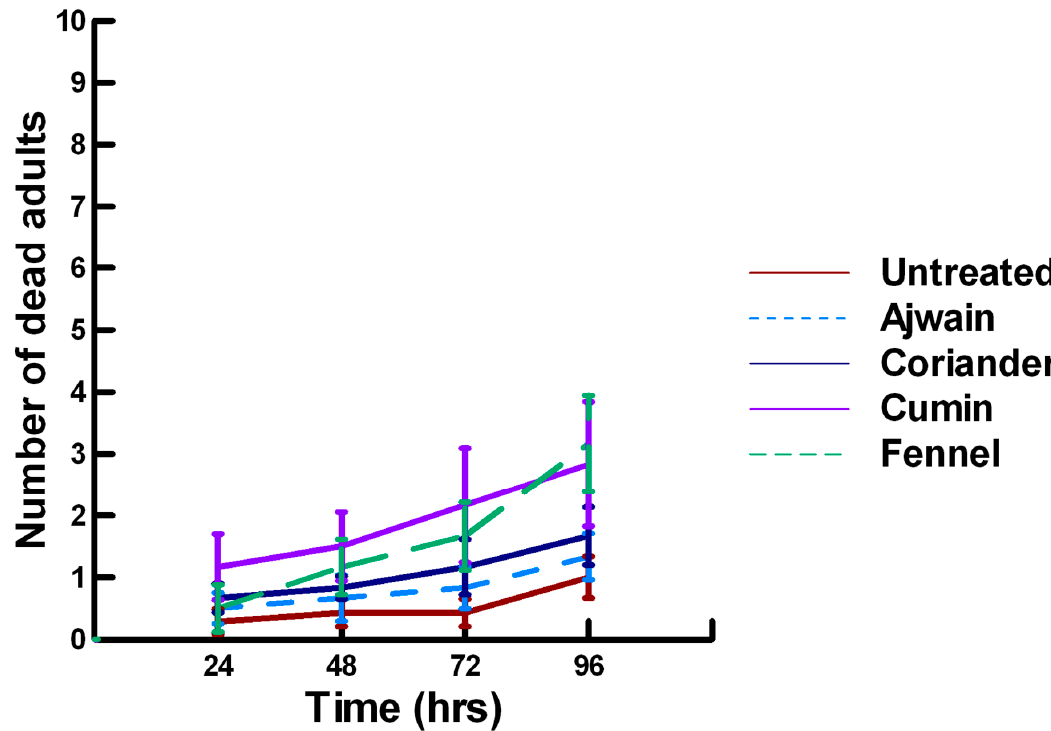
Figure 12. Acute contact toxicity with a high concentration of plant powders from the family Apiaceae (Ajwain, coriander, cumin and fennel) adherent to male adult Megachile rotundata (ALBs). Means and standard error shown.